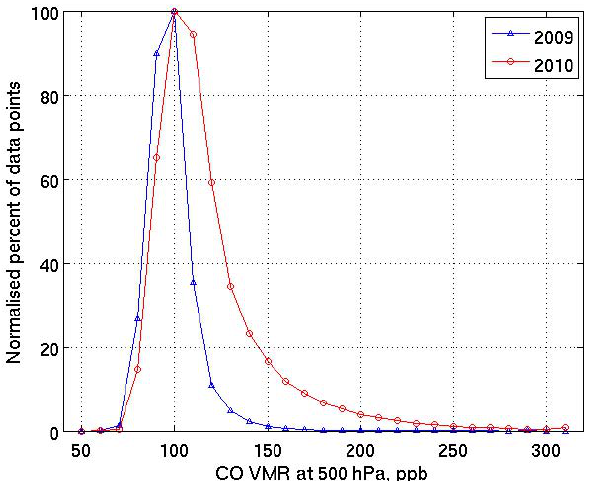
Fig. 10. Histograms of CO VMR-500 retrieved from AIRS spectra for Russia during the period between 2 August and 9 August for 2009 and 2010. Two plume threshold values,150ppb and 170ppb, are used to calculate the plume areas in 2010.